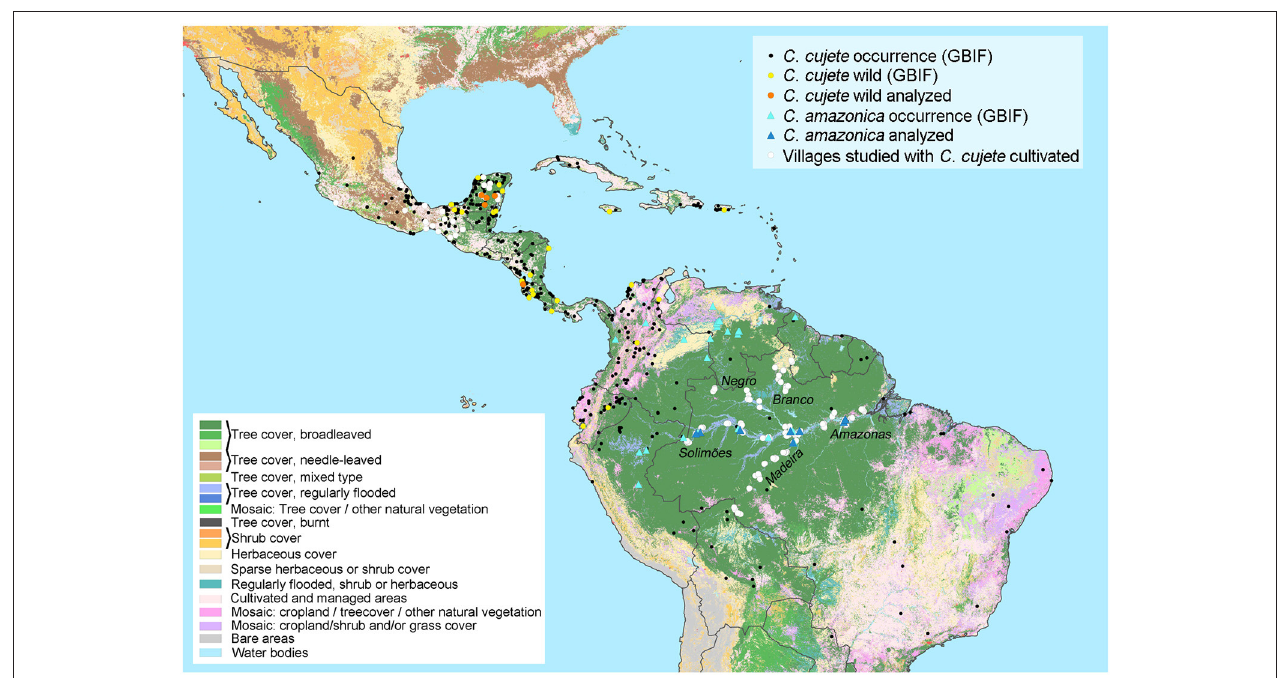
FIGURE 1 | The geographical distribution of cultivated Crescentia cujete , putative wild populations of C. cujete and wild C. amazonica in the Neotropics. Genetic or morphological analyses include samples from Mexico, Costa Rica and five rivers in Brazilian Amazonia (Negro, Branco, Solimões, Madeira, Amazonas). Their distributions were complemented with records from the Global Biodiversity Information Facility (GBIF) and plotted over the vegetation cover (Bartholomé and Belward, 2005). The wild C. cujete distribution was hypothesized based on apparently spontaneous individuals growing in a mosaic of shrub and grass cover, which does not rule out previous human dispersion, since areas might include abandoned or burned